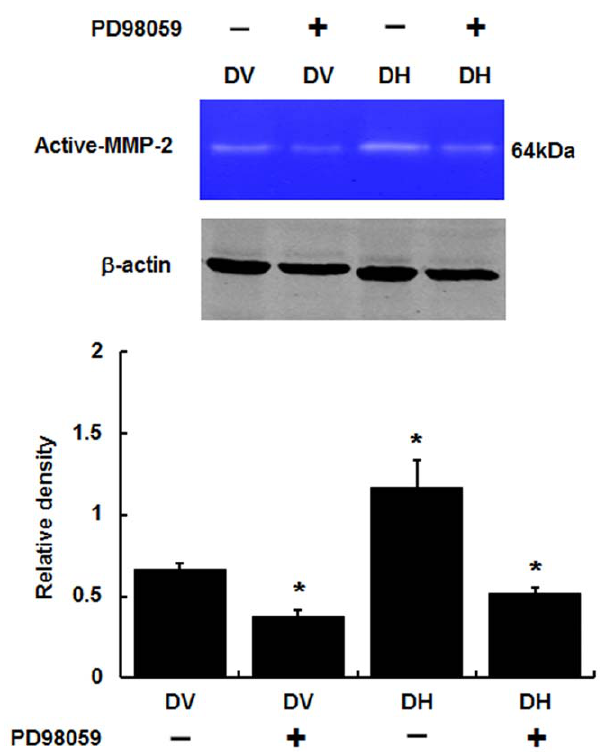
Figure 5. HCG b increased MMP-2 activity via ERK1/2. We collected the conditional medium from the above treatment was for geltin zymography assay as the Methods. The results showed that hCG b increased MMP-2 activity and PD98059 reduced those effects. *, indicates P , 0.05 versus control. Data were shown as means 6 SEM from three separate tests. The lower panel of gel pictures showed an equal loading that a parallel SDS gel was run to test b -actin via Western